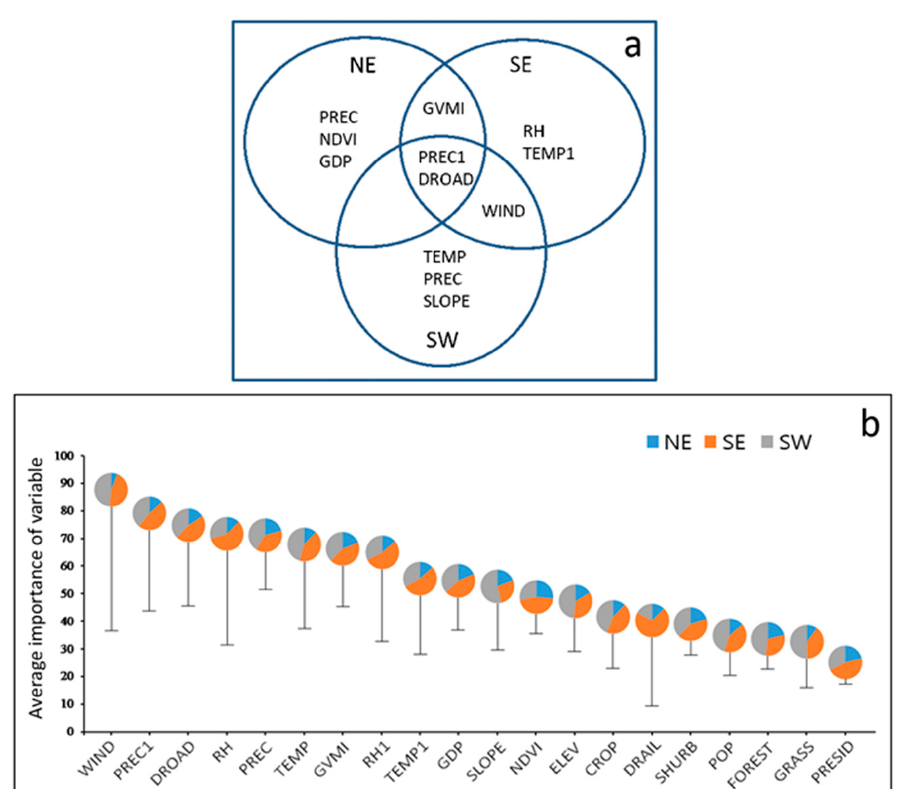
Figure 5. The first six important fire drivers in different regions ( a ). Comparison of the relative importance of variables to fire occurrence (pie charts) and the relative importance of each variable among the three regions (different portions within each pie chart) ( b ). Abbreviated variable names are described in Table 3. Table 3. Results of the models created with Random Forest under different category of variables in each region, including the correlation values between observed (obs) and predicted (pred) values.